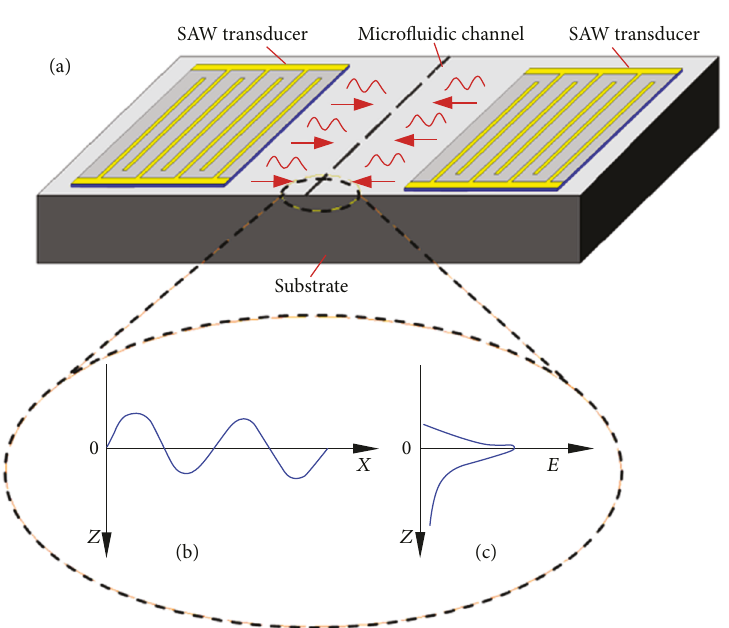
Figure 3: Schematic diagram of ultrasonic separation